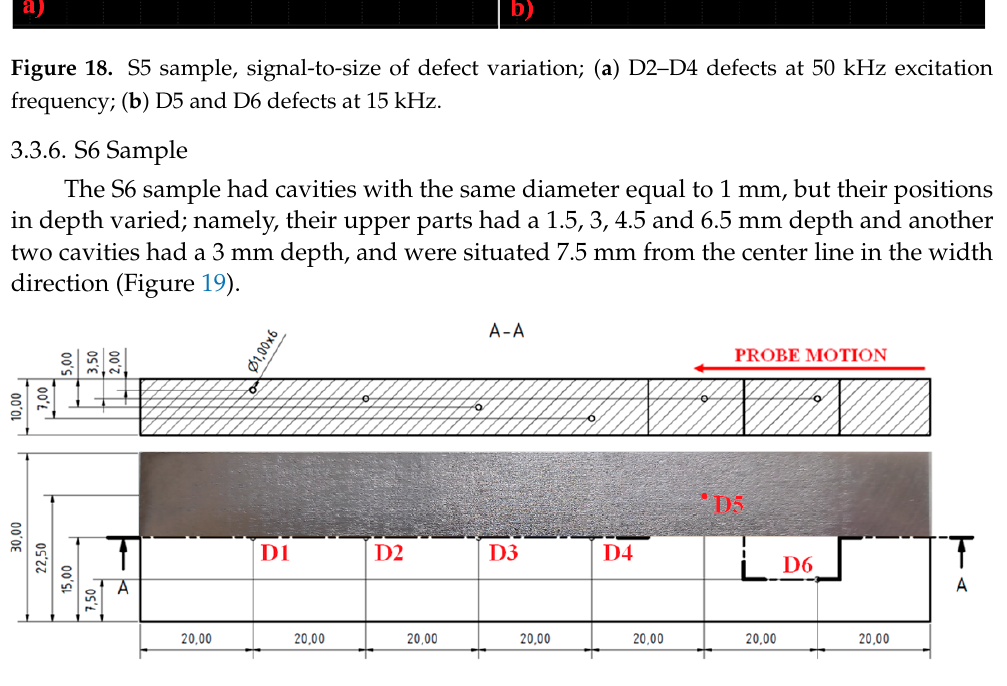
Figure 20. S6 sample, signal-to-depth of defect variation at 25 kHz excitation frequency. Additionally, D6 defects in the signal variations in the S2, S3, S3 (reversed) and S5 samples at the same frequency (10 kHz) were compared for the SWEEP regime in the same way as the IMPEDANCE regime (Figure 21). It can be seen that the biggest signal variation was obtained in the case of the blind hole (reversed S3) measured on the side, where it reached the surface (Figure 21c). Con- cretely, the Vmax was 4.7 and Hmax was 3,4. Smaller values were reached in the case of a groove on sample S2, mainly for the Hmax (Figure 21a). This was because the smaller density of the eddy current was disturbed by the groove in comparison with a hole. Both (S2, reversed S3) of the obtained signals had much smoother curves than S3 (Figure 21b) and S5 (Figure 21d). This was because the defects in the S3 and S5 samples were under the surface and the signal was more attenuated, which caused the noise. Additionally, a higher GAIN was set for these two samples for a better depiction. If the shape of the signal